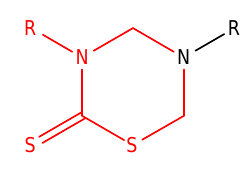
Figure 2 . THTT prodrug system for amines and amino acids.